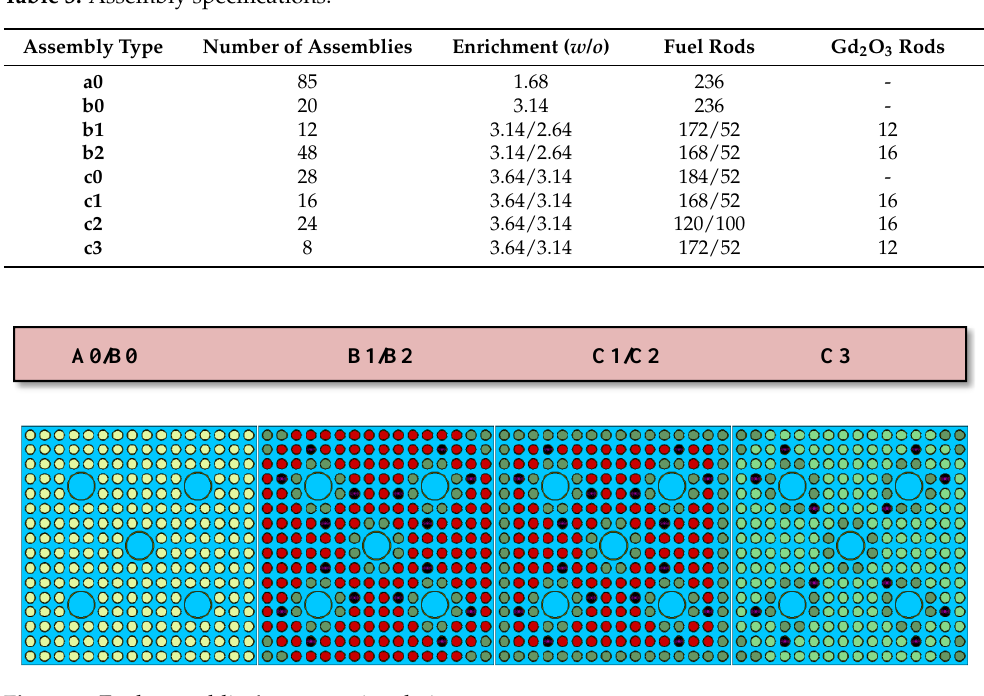
Figure 1. Fuel assemblies’ cross-sectional view.